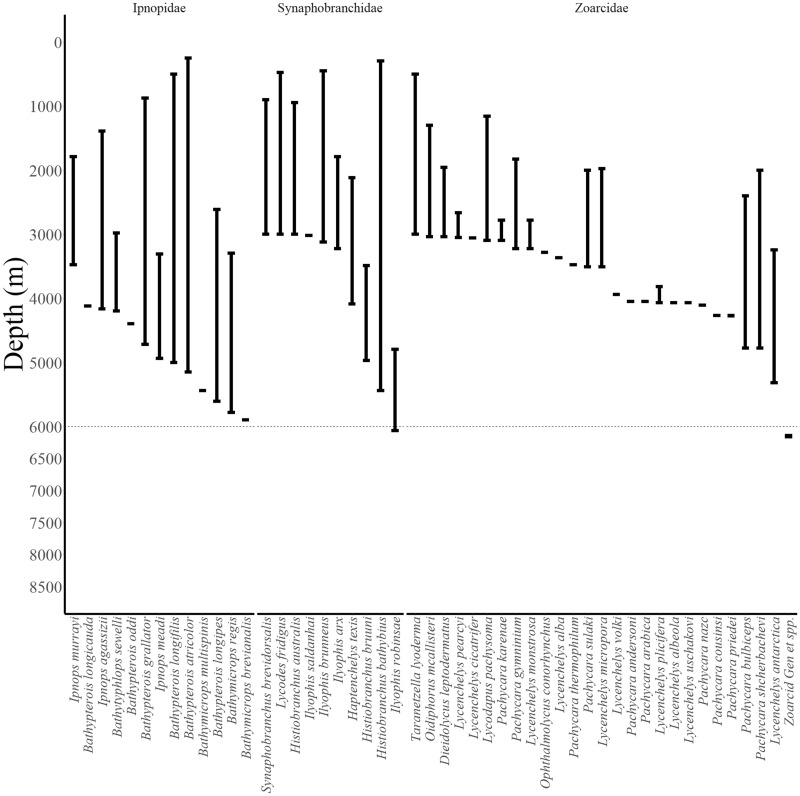
Reported depth distributions of deep-dwelling fishes (collections >3000 m) by family (Ipnopidae, Synaphobranchidae, Zoarcidae). Abyssal–hadal boundary at 6000 m shown as dotted line. Data from FishBase (Froese and Pauly 2014) checked in the primary literature (Nielsen 1977; Andriashev and Stein 1998; Nielsen et al. 1999; Chernova et al. 2004; Chernova 2006; Duhamel and King 2007; Moller and King 2007; Jamieson et al. 2009; Linley et al. 2016, 2017; Gerringer et al. 2017b). See Supplementary Note 1 for notes on record verifications.